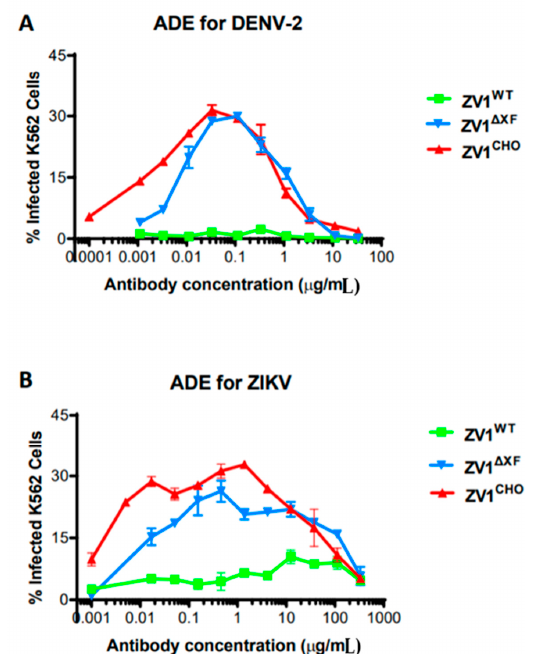
Figure 3. Antibody-dependent enhancement (ADE) of ZV1 glycovariants for DENV and ZIKV infection. Serial dilutions of ZV1 glycovariants were mixed with DENV-2 ( A ) or ZIKV ( B ) and then incubated with Fc γ RIIa + K562 cells. After incubation, cells were fixed, permeabilized, and stained with an anti-flavivirus E antibody and then analyzed by flow cytometry to identify DENV-2 or ZIKV-infected cells. Results (Mean ± SD) from at least two independent experiments with technical triplicates for each sample are presented. 3.5. Antibody-Dependent Cellular Cytotoxicity of ZV1 Glycovariants